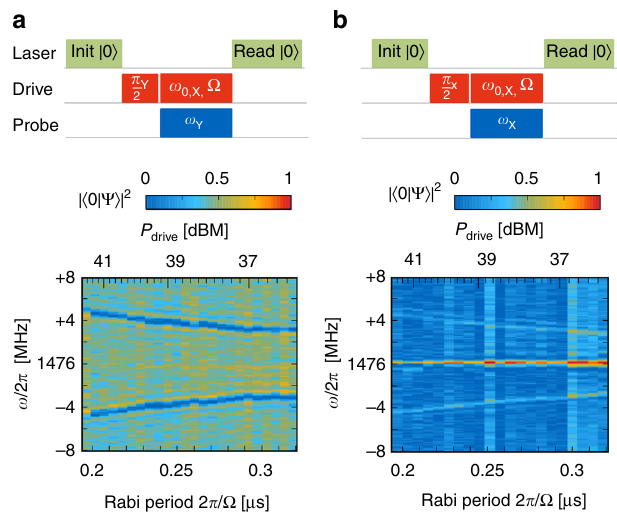
Fig. 2 Mollow absorption. a A weak probe with phase orthogonal to a strong drive fi eld drives the sideband transition at ω = ω 0 ± Ω . Measurements were performed on an NV center with optical initialization and readout (green laser pulses). The duration of the drive (~1.3 μ s) was adjusted for every drive fi eld power Ω (set by the microwave power P drive ) to correspond to an integer number of π rotations. b A weak probe in phase with the strong drive fi eld drives the central transition ω